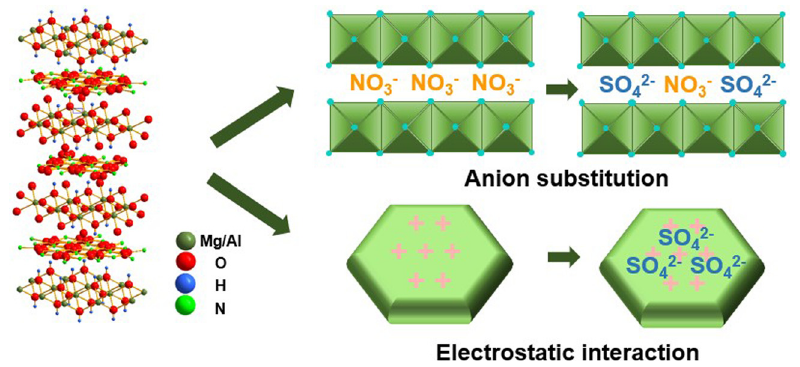
Figure 9: The schematical mechanism of the adsorption e ff ect.